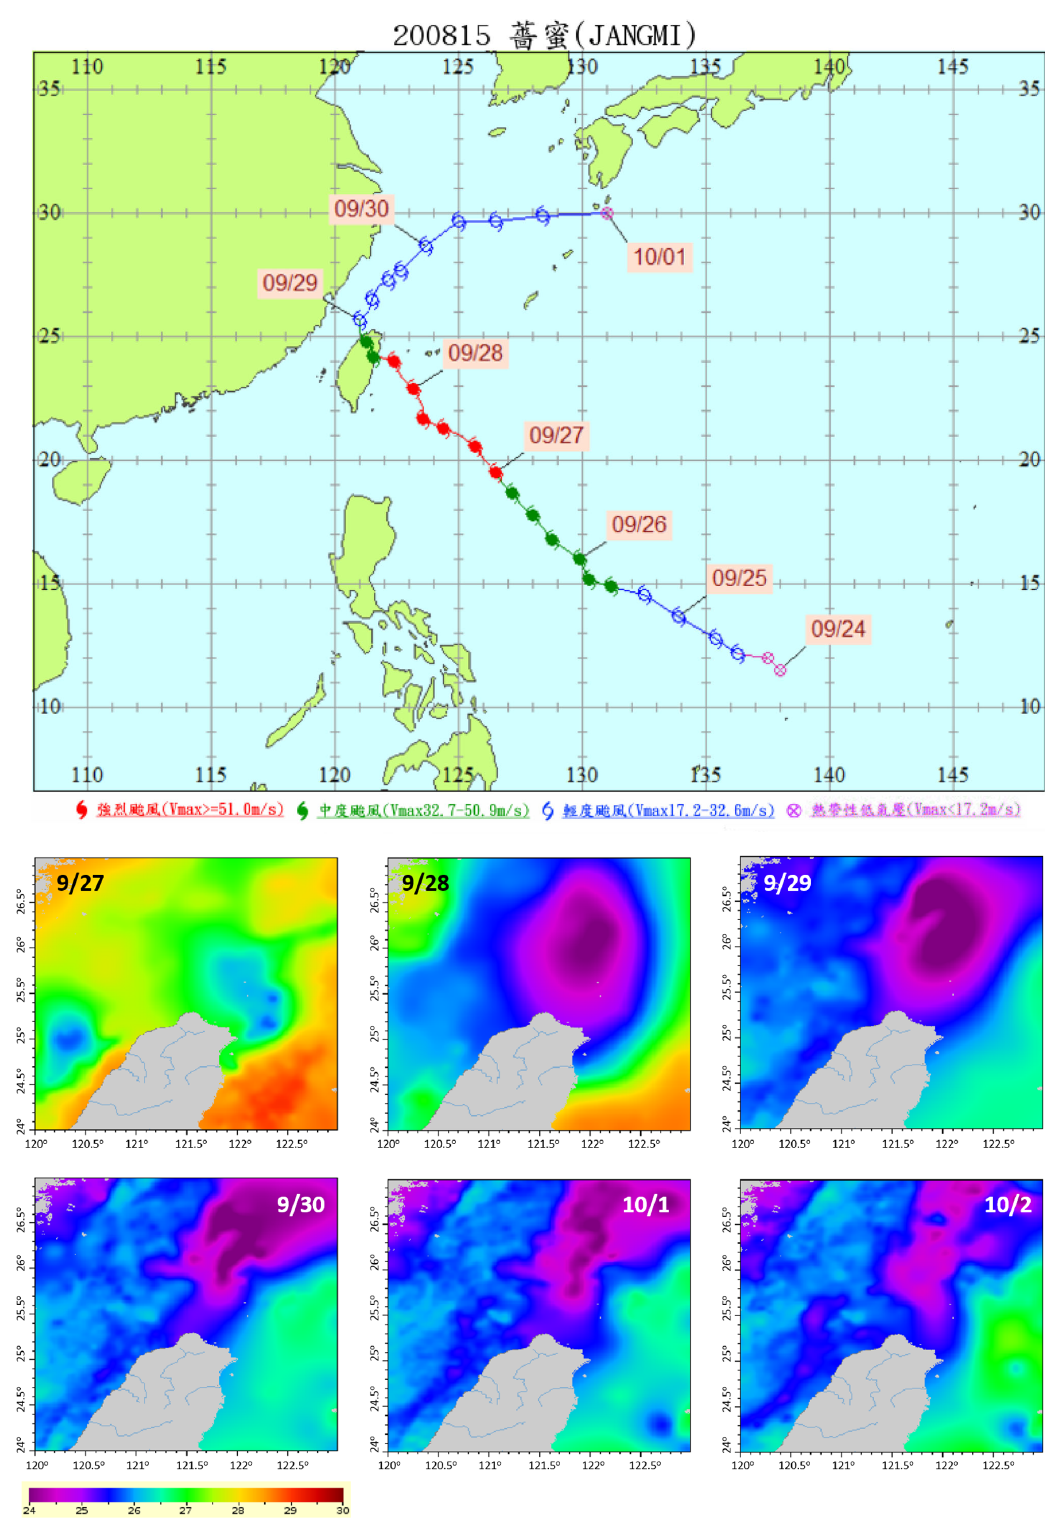
Figure 11. Movement of the cold dome off northeastern Taiwan during Typhoon Jangmi in 2008. The typhoon track is shown in the upper panel. The lower panel shows the satellite images of the